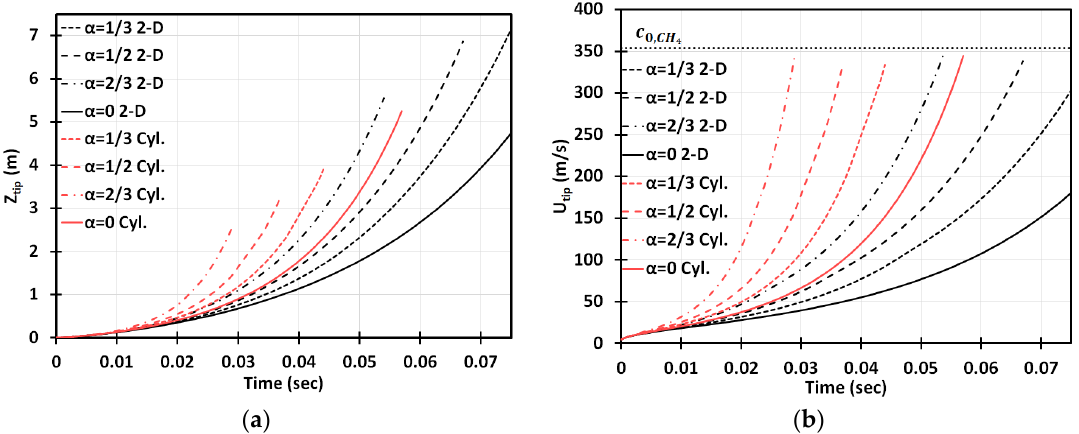
Figure 4. Comparison of the 2D and cylindrical-axisymmetric geometries. Time evolution of the flame tip position Z tip ( a ) and velocity U tip ( b ) for stoichiometric CH 4 -air burning with various blockage ratios α = 0, 1 3,⁄ 1 2,⁄ 2 3⁄ .